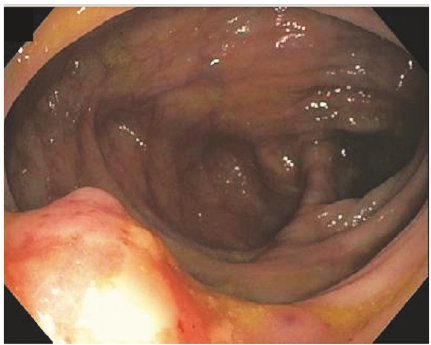
Figure 1: The nodule was visualized at the hepatic flexure with mild ulceration and bleeding at the surface. Ulceration and blood loss were the presumed explanation for the patient’s chronic iron deficiency.